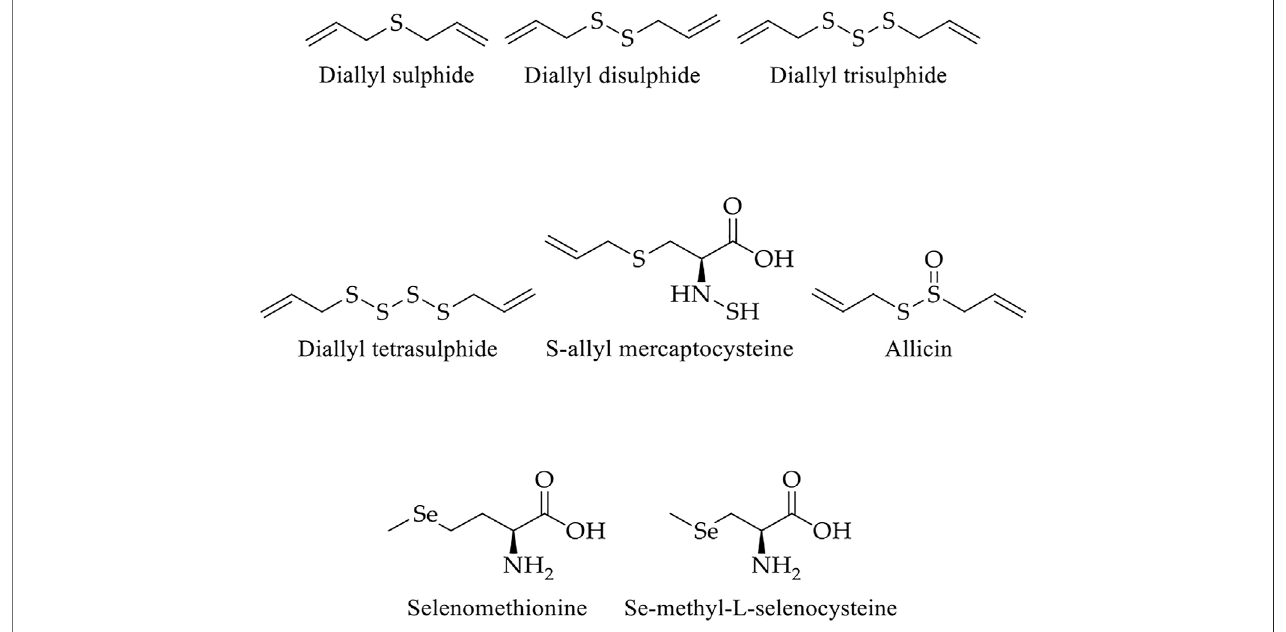
FIGURE 9 | Chemical structure of main bioactive compounds of